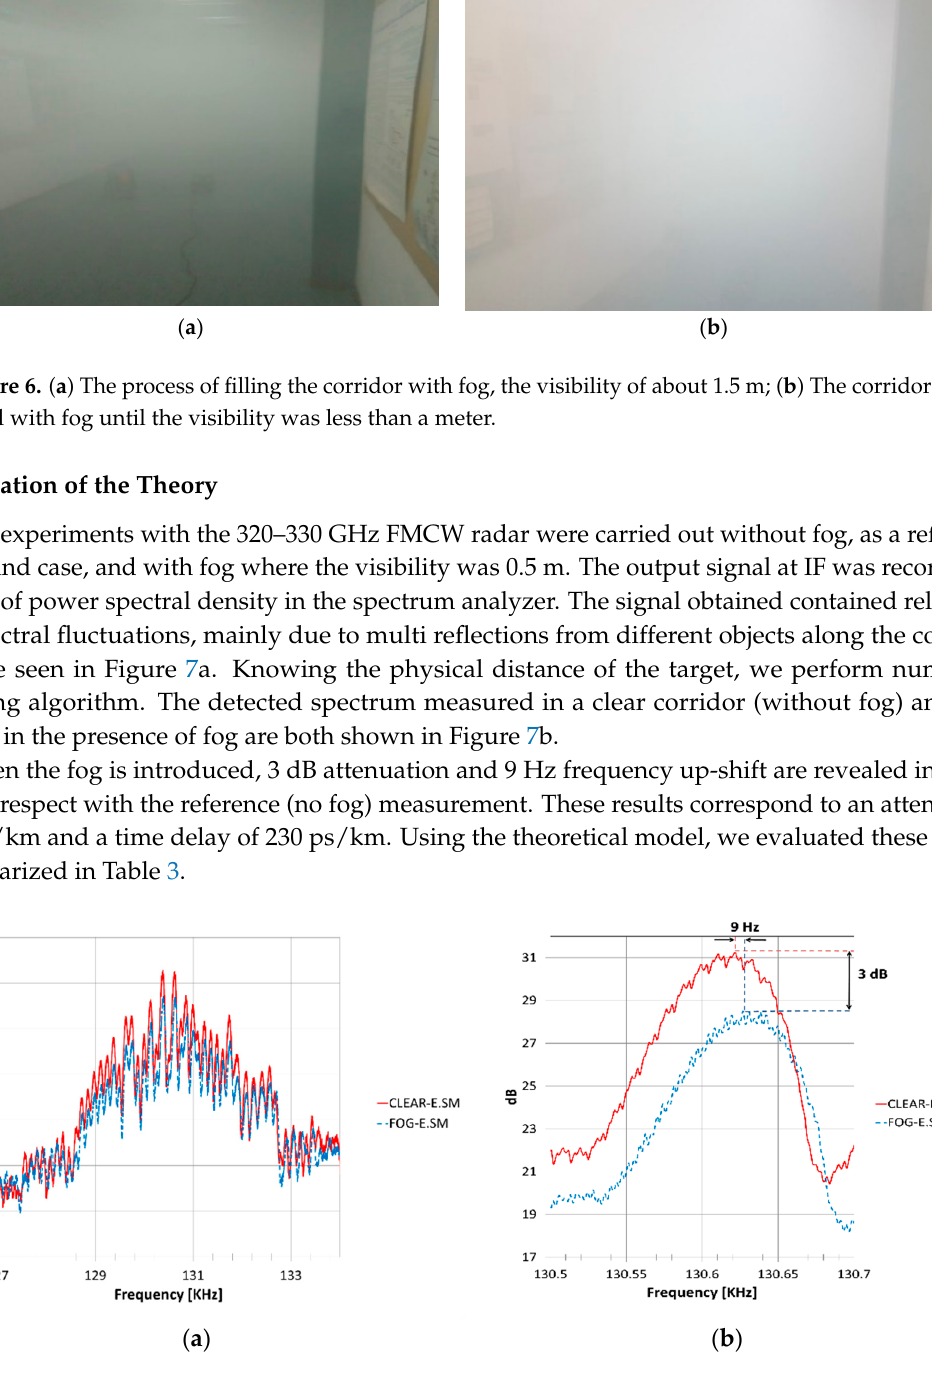
Figure 5. The corridor and the fog streaming start-up. The composition of the artificial fog was based on aqueous glycol solution. The solution components and their respective refractive index were triethylene glycol ( n = 1.4531), 1,3-butylene glycol (1.4401), propylene glycol (1.4324), and deionized water (1.330). Since the weight percentage of each component was not provided by the manufacturer, an estimation was made for the refractive index as 1.439 [29]. The initial thermal conditions along the corridor were 16 °C and 70% relative humidity. The